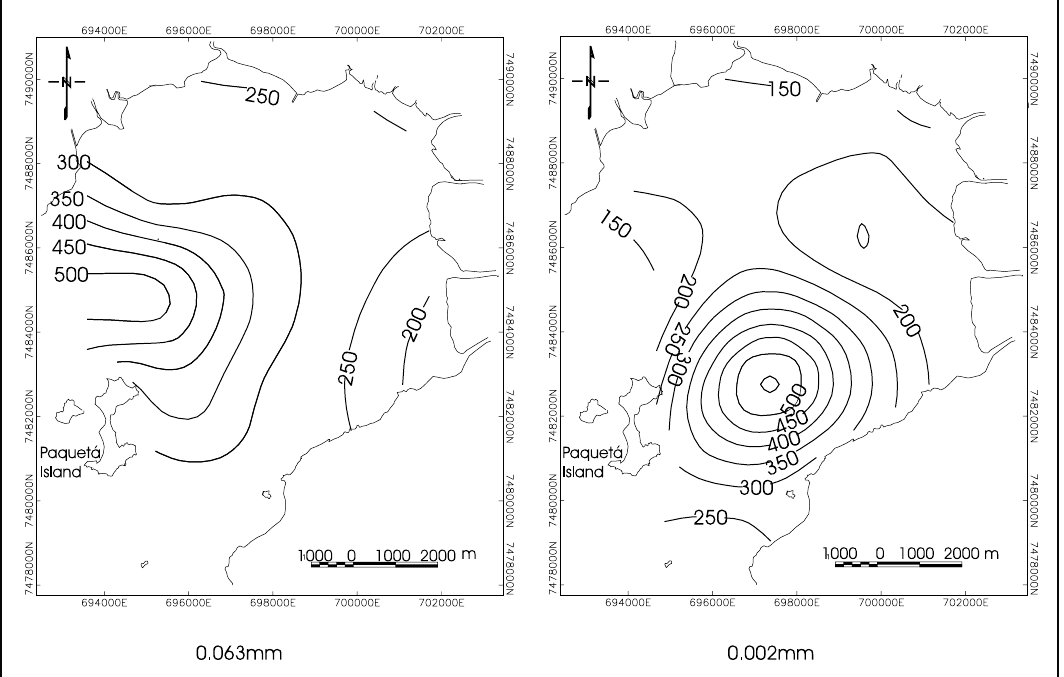
Fig. 8 – Zn distribution in bottom sediments of northeastern Guanabara Bay (contour lines are in ppm).